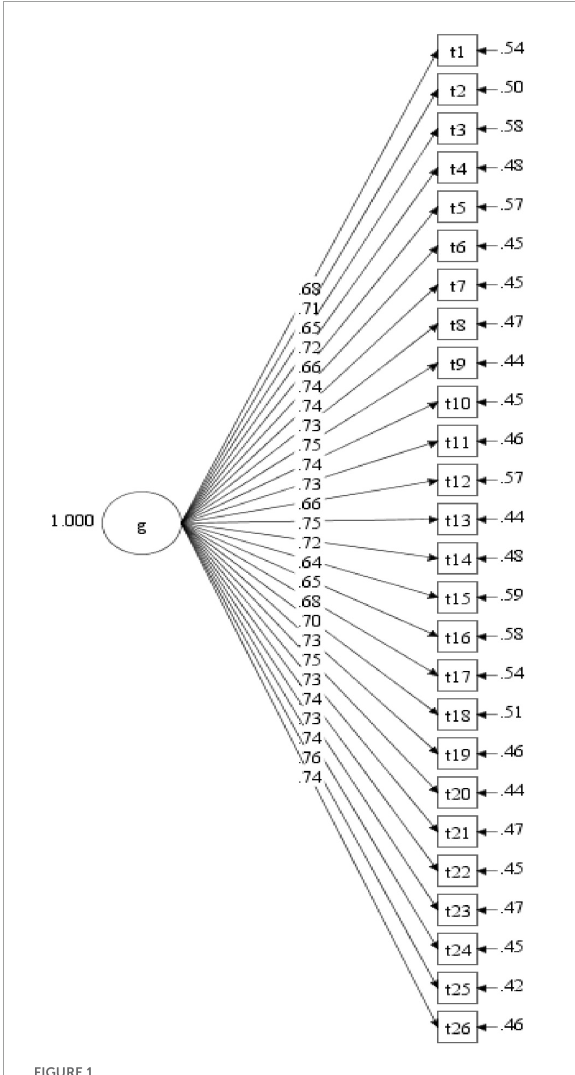
FIGURE1 Factor loadings for the single-factor